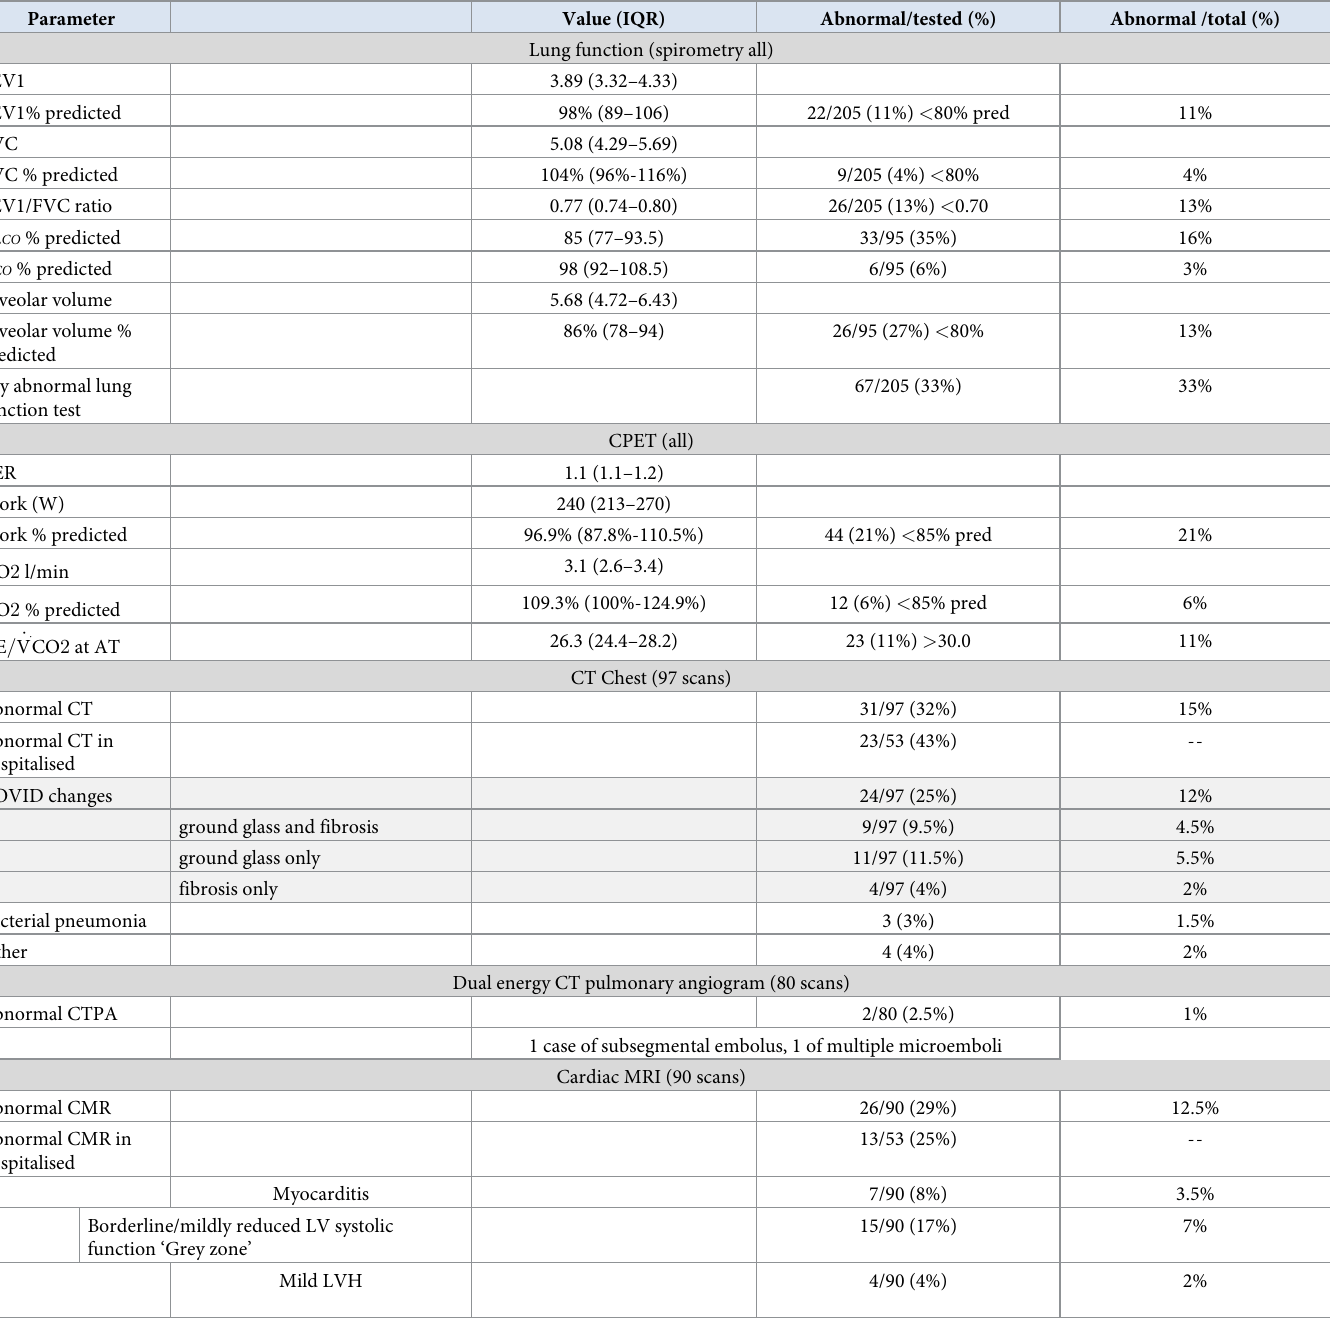
Table 6. Full results of clinical